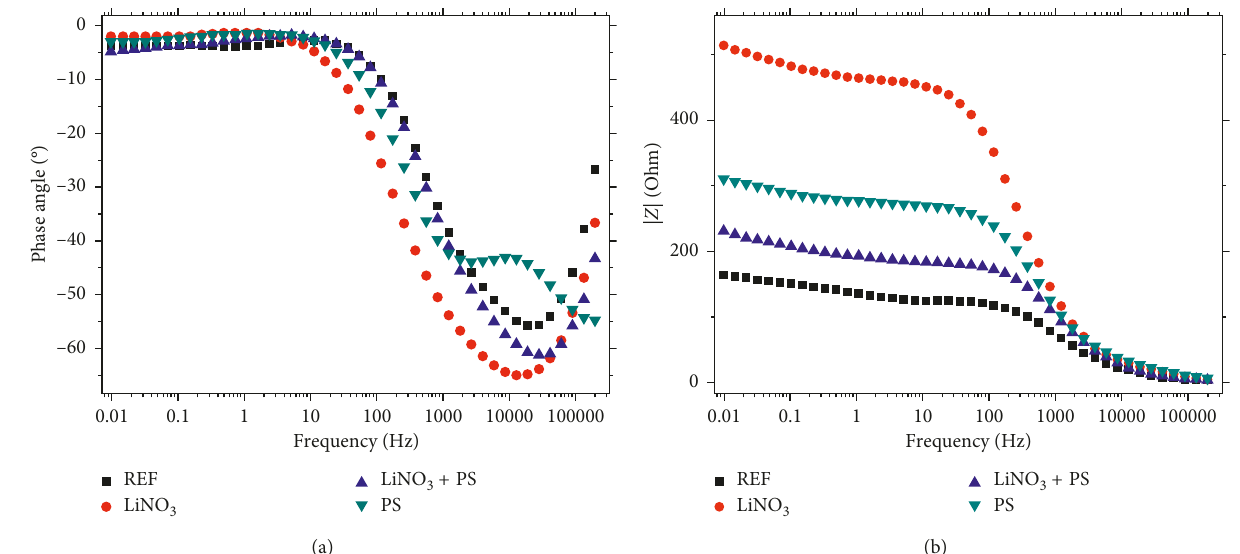
Figure 2: Bode phase (a) and total impedance (b) diagrams for anodes tested in symmetric cell, after 20h contact time with the electrolyte 1M LiTFSI, DOL/TEGDME (7: 3) (black); 1M LiTFSI, 0.2 M LiNO 3 , DOL/TEGDME (7: 3) (red); 1M LiTFSI, PS DOL/TEGDME (7: 3) (green); and 1M LiTFSI, 0.2M LiNO 3 , PS DOL/TEGDME (7:3)